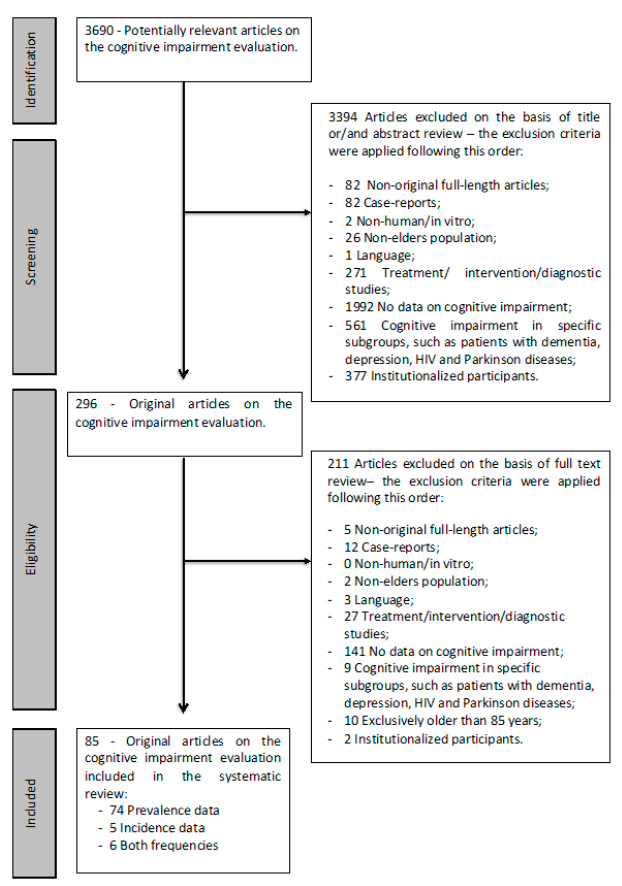
Figure 1. Flow chart summary of the literature